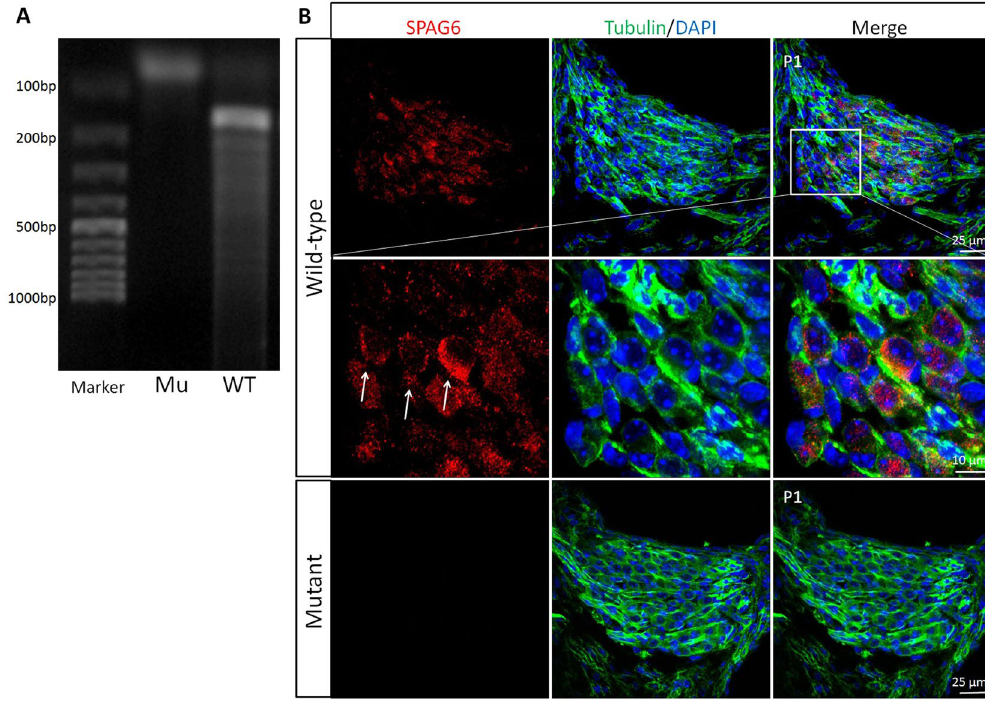
Figure 1. SPAG6 is expressed in mouse SGNs ( A ) RT-PCR showed SPAG6 expression in postnatal 1 day (P1) wild-type mouse SGNs at a band of 190 bp, while there was no detectable band in the mutants. ( B ) immunofluorescence showing positive staining of SPAG6 (red), β -tubulin Ш(green, neuronal specific marker) and DAPI (nucleus). SPAG6 was located primarily in the cytoplasm around the nucleus of SGNs (arrows) at